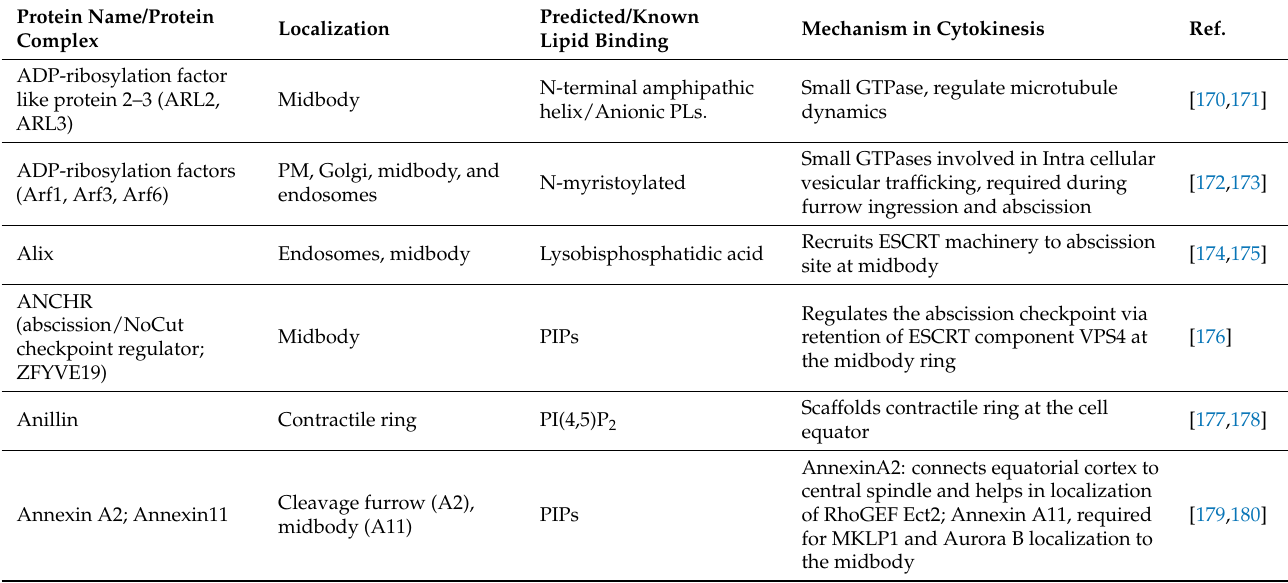
Table 1. Membrane/Lipid binding proteins involved in